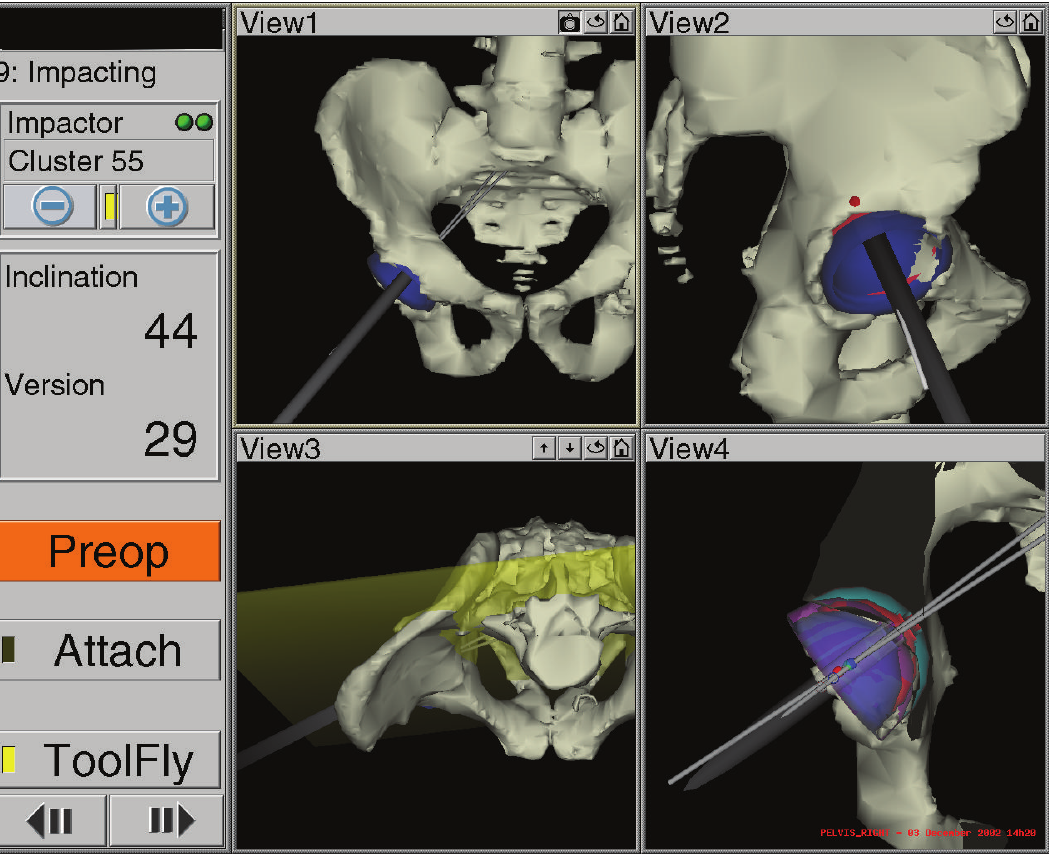
Figure 1: Representation of the preop cup placement (red) and the real cup position (blue) during the impacting process. An actual inclination of 44 ◦ and an anteversion of 29 ◦ are shown from an AP view (top left), a right side view (top right), and a top view including a yellow cutting plane that permit the visualization of the posterior portion of the pelvis (bottom left) and the planned cup (red) and navigated cup (blue) (bottom right).